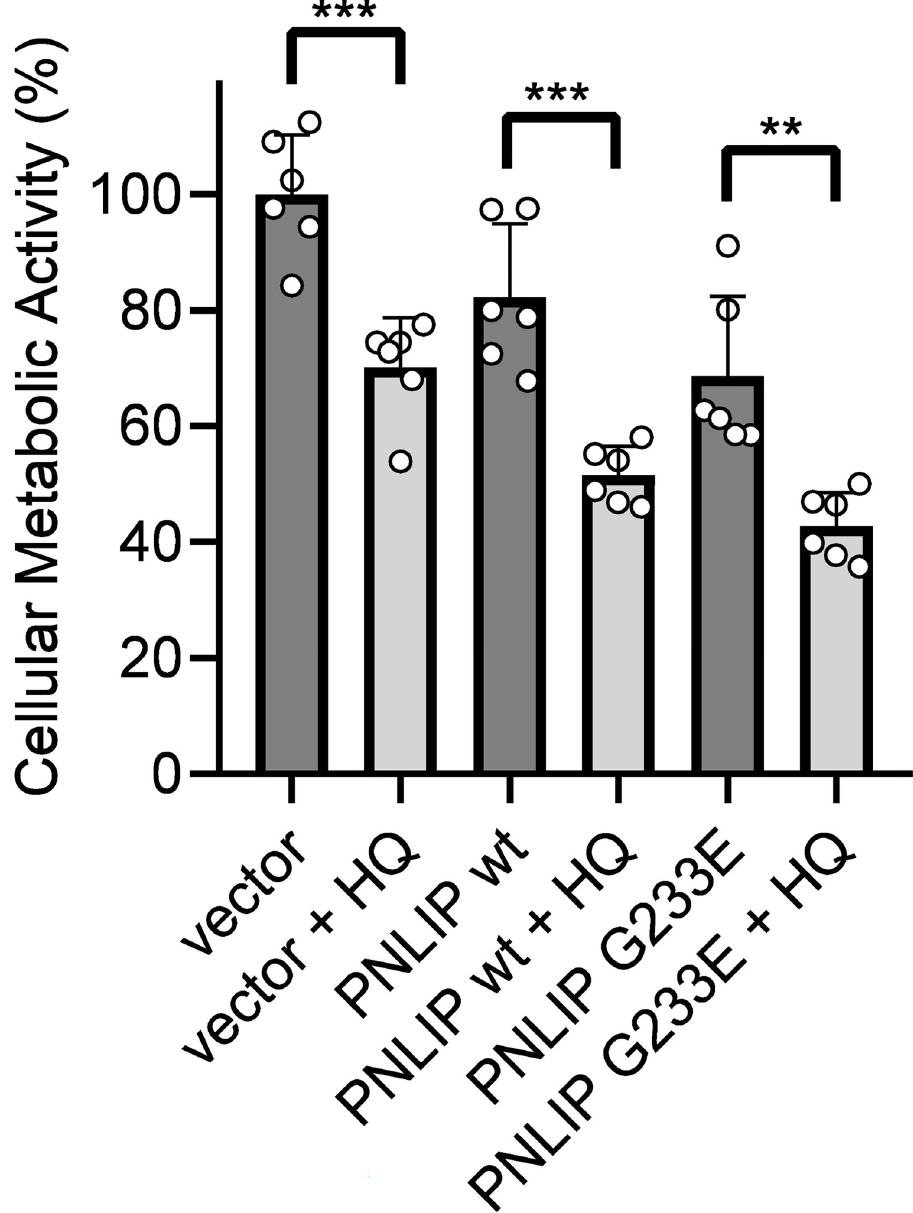
Fig 3. Effect of hydroquinone (HQ) on the viability of wild-type and G233E mutant PNLIP expressing HEK 293AD cells. One day post-transfection, cells were incubated in the absence or presence of 25 μ M HQ for 24 h at 37 ˚C, and the levels of cellular metabolic activity were analyzed by MTT assay as described in Materials and Methods. Cells transfected with empty pcDNA3.1(-) vector were used as control. Data points represent the average of 6 independent experiments with SD. �� P � 0.01; ��� P �